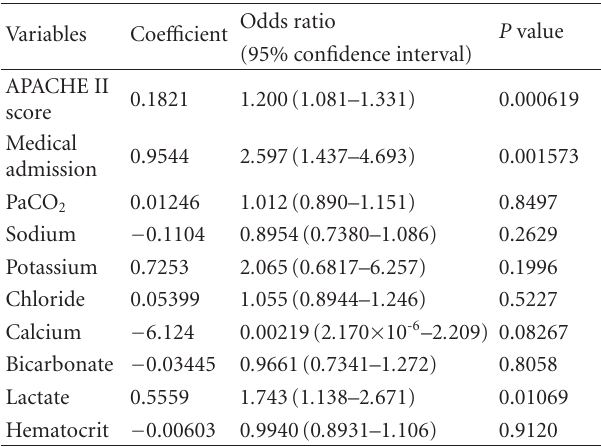
Table 5: Logistic regression model for